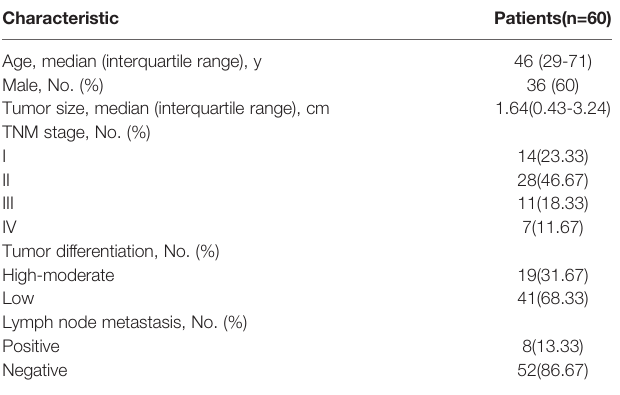
TABLE 1 | Patient samples